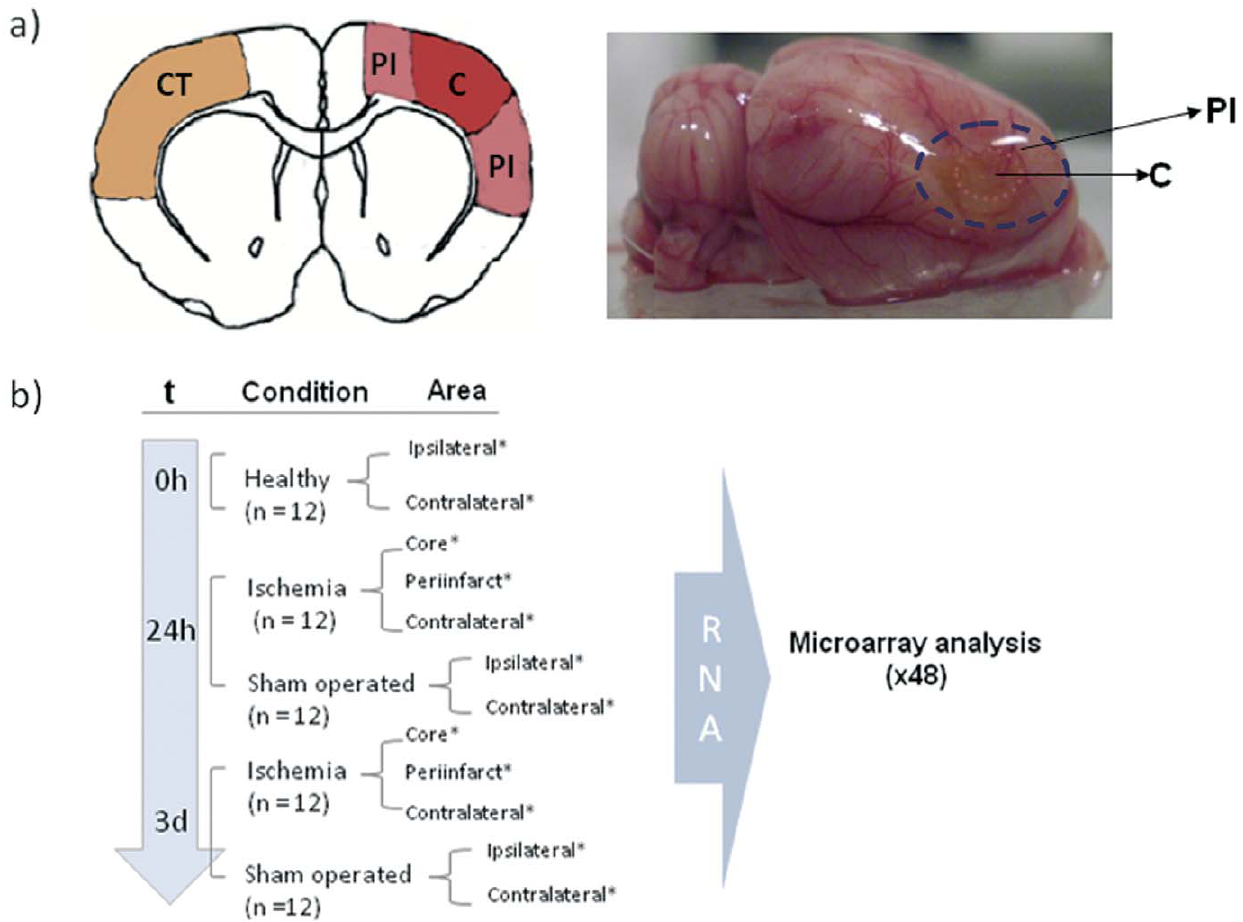
Figure 1. The pMCAO model produced cortical infarcts where core, periinfarct, and contralateral areas were isolated for RNA extraction. Sprague-Dawley rats were subjected to permanent middle cerebral artery occlusion with a 9-0 suture for 24 h or 3 d (a) Schematic drawing of brain areas used for tissue sampling and RNA extraction. (b) Panel shows workflow and study groups used (n=12 animals/condition). *=4 RNA pools/condition (1 pool=3 animals=1 microarray). (CT: Contralateral cortex; PI: Periinfarct; C: